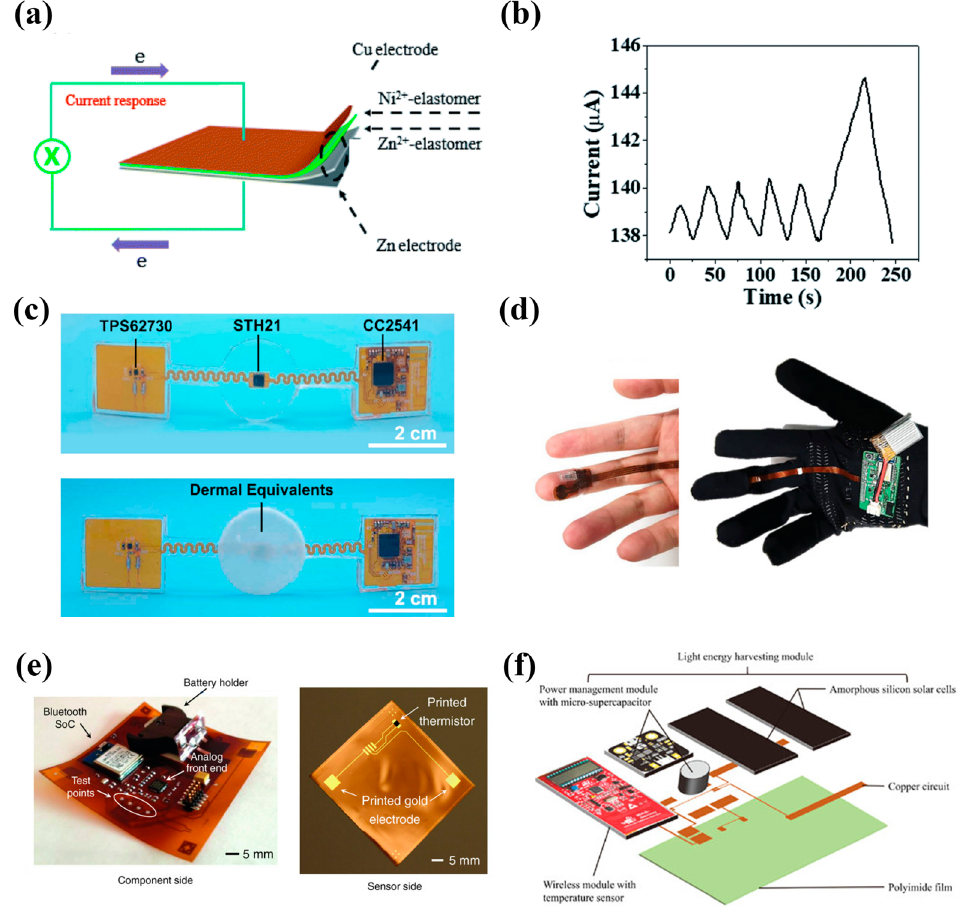
Figure 6. ( a ) Schematic diagram of the galvanic cell. ( b ) The current change of contactless temperature-detection. Reprinted with permission from Ref. [106]. Copyright 2022, Journal of Materials Chemistry A. ( c ) Schematic of the wireless sensing system for wound temperature monitoring. Reprinted with permission from Ref. [35]. Copyright 2020, Biosensors and Bioelectronics ( d ) Photograph of the integrated system for skin moisture and temperature wireless monitoring. Reprinted with permission from Ref. [107]. Copyright 2021, Advanced Healthcare Materials. ( e ) Photograph of the component side and the sensor side (before component assembly) of the patch. Reprinted with permission from Ref. [108]. Copyright 2016, Advanced Functional Materials. ( f ) Illustration of structural formation of LTSP. Reprinted with permission from Ref. [109]. Copyright 2021, ACS Applied Electronic Materials.